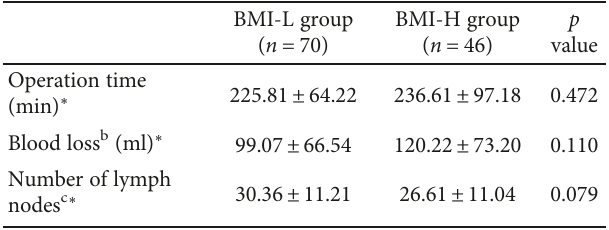
Table 4: Comparison of the intraoperative outcomes between the low-BMI group and high-BMI group carrying out without conversion to laparotomy.